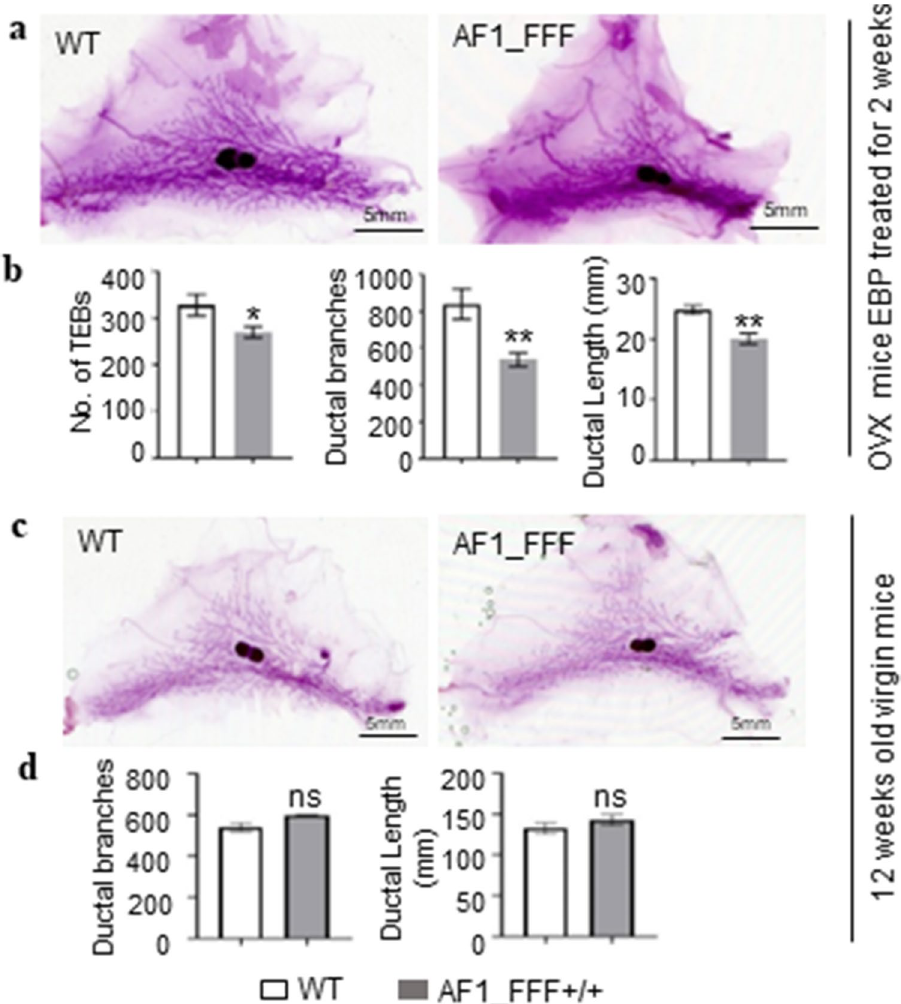
Figure 2. AF1_FFF mutations result in reduced mammary development in response to EBP but have no effect on intact nulliparous mice. ( a , b ) Mice ovariectomizd at 6 weeks old were treated with EBP for two weeks before whole mount analysis of the 4th mammary gland. ( a ) Representative whole mount images; ( b ) quantification of the TEB, ductal branching and ductal length by image analysis (n = 5 for WT and n = 6 for AF1_FFF). ( c , d ) No difference in mammary development between the WT and AF_FFF mutant virgin mice at 12 weeks old. ( c ) Representative whole mount images; ( d ) quantification of the ductal branching and length (n = 4 for each genotype). All numeric data are expressed as mean ± SEM, *p < 0.05; **p < 0.01, ns not